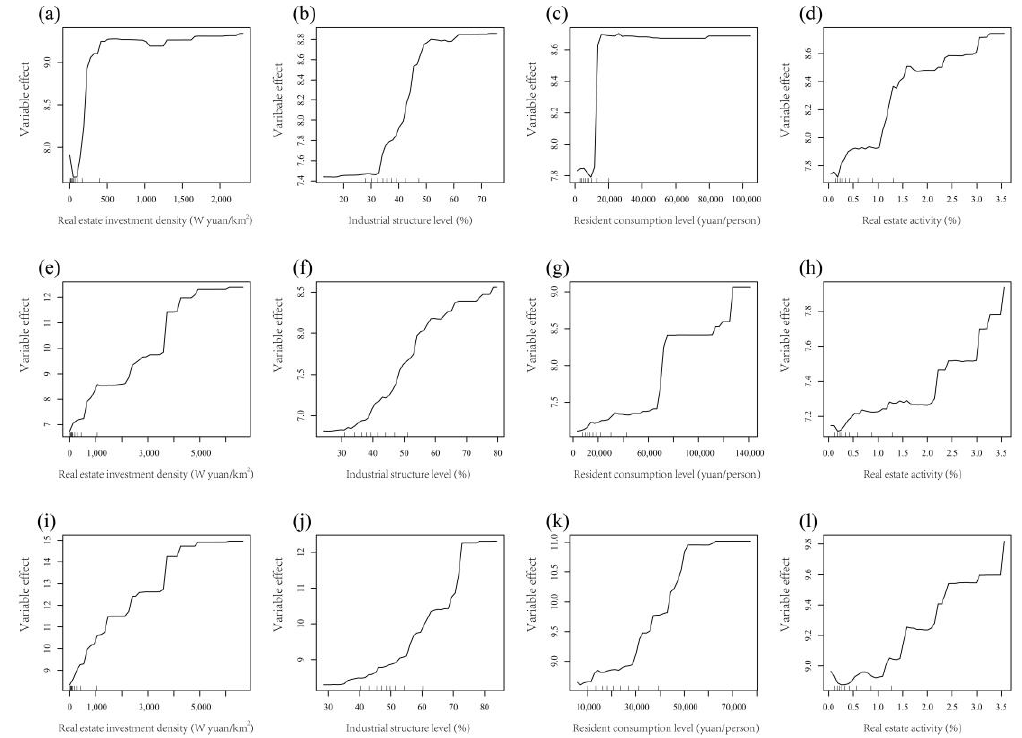
Figure 3. The partial dependence of dominant factors on PIR. ( a ) real estate investment density in 2009, ( b ) industrial structure level in 2009, ( c ) resident consumption level in 2009, ( d ) real estate activity in 2009, ( e ) real estate investment density in 2015, ( f ) industrial structure level in 2015, ( g ) resident consumption level in 2015, ( h ) real estate activity in 2015, ( i ) real estate investment density in 2020, ( j ) industrial structure level in 2020, ( k ) resident consumption level in 2020, ( l ) real estate activity in 2020. W yuan represent ten thousand yuan.